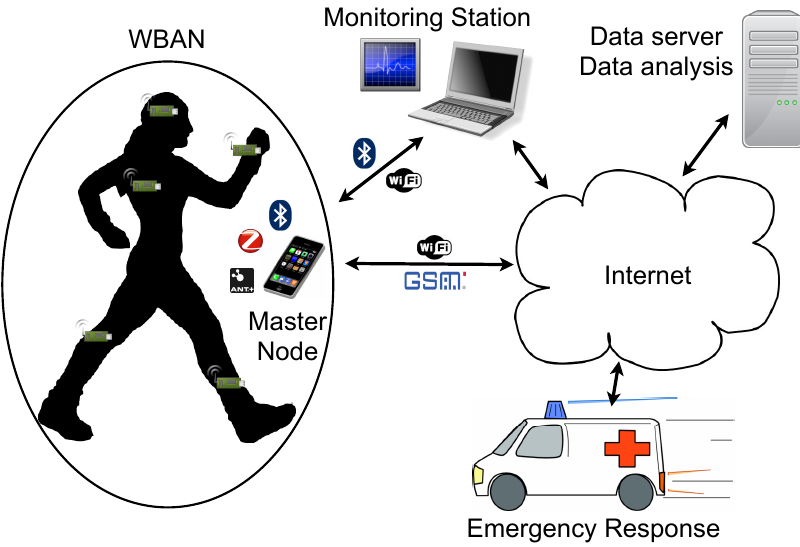
Figure 1. Example of WBAN